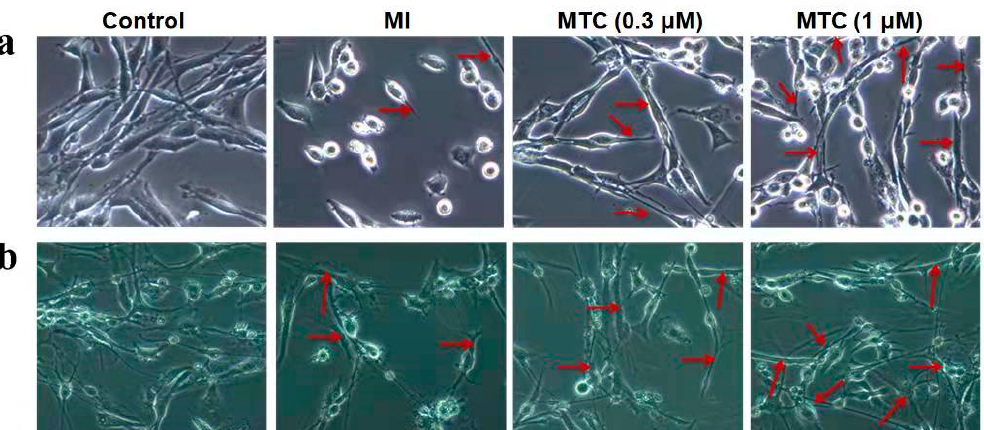
Figure 6. ( a ) Effects of post-treatment with MTC for 24 h on axonal growth of PC12 cells induced by ischemia-reperfusion injury; ( b ) Effects of post-treatment with MTC for 24 h on axon growth of primary neurons in rat induced by ischemia-reperfusion injury.